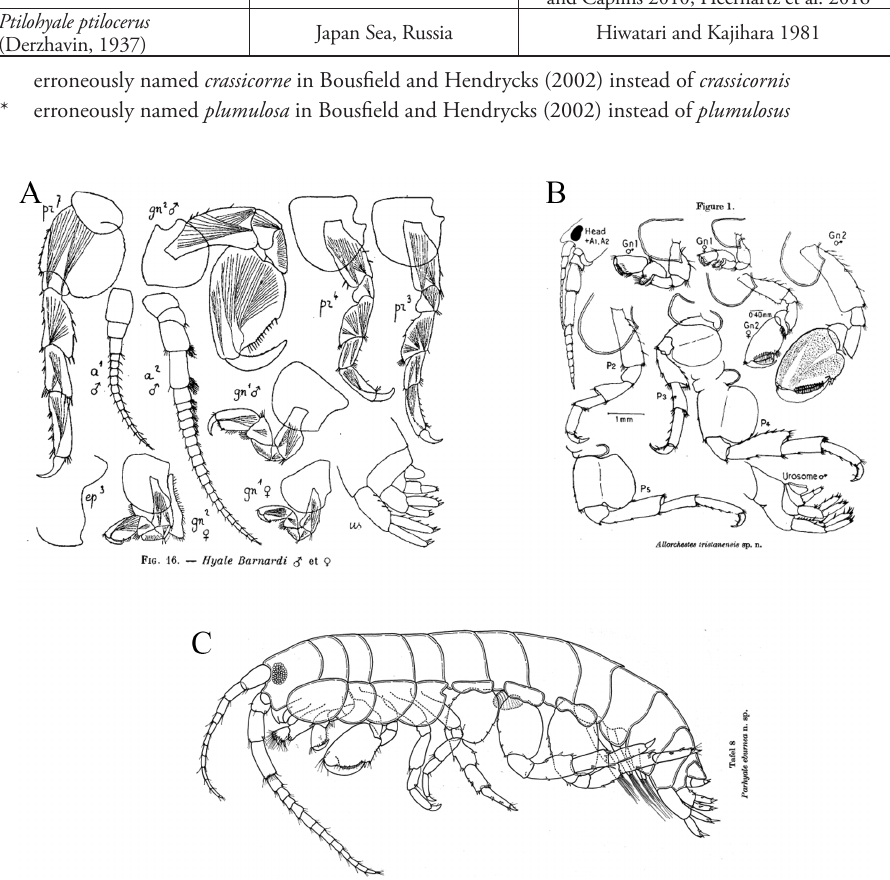
Figure 4. Illustrations from the literature of: A Ptilohyale barnardi (Chevreux, 1925) B Ptilohyale tristan- ensis (Macnae, 1953) C Ptilohyale eburnea (Krapp-Schickel,